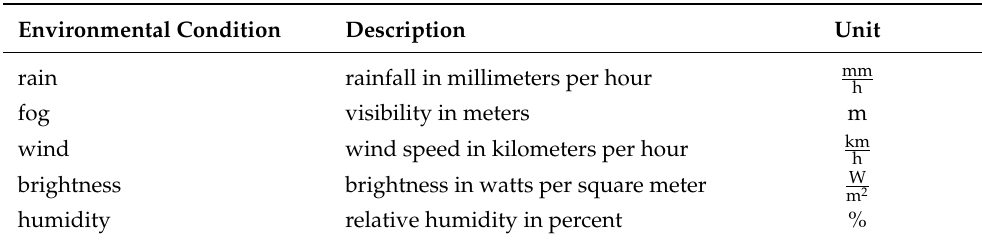
Table 3. Overview of the selected environmental conditions in the research project “Agro-Safety”, measured by the weather station next to the test stand.